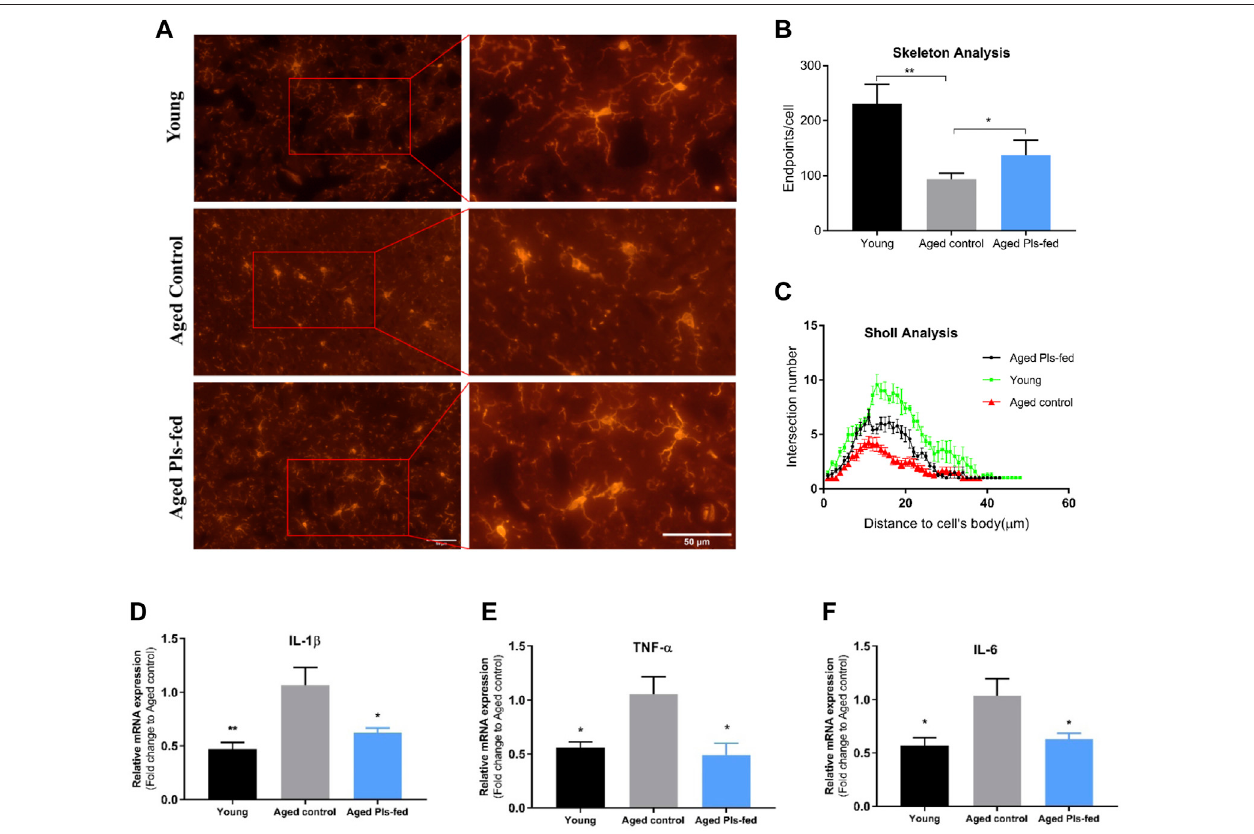
FIGURE 7 | Effects of plasmalogens intervention on microglia activation and in fl ammatory cytokines expression. (A) Immuno fl uorescence staining of Iba1+ microgliacells(red)inthehippocampusofyoungcontrol,agedcontrolandagedPls-fedmice,scalebars,50 μ m.Notethatmicrogliaofagedcontrolmicedisplayshorter processes and diminished rami fi cation of processes, whereas microglia of aged Pls-fed and young control show longer and rami fi ed processes. (B) The graph bar of skeletonanalysison microglia showed thatthe endpoints are increased in microglia ofaged Pls-fed mice. (C) Sholl analysisofthe number ofbranches plotted asa distance from cell body ( n = 30, microglial cells per experimental group). (D – F) The real-time PCR data showed mRNA expression of pro-in fl ammatory cytokines IL-1 β , TNF- α , IL-6 in hippocampus of young control, aged control and aged Pls-fed mice. All values are presented as mean ± SEM. Asterisks indicate statistical signi fi cances compared to Aged control by one-way ANOVA (* p < 0.05; ** p <